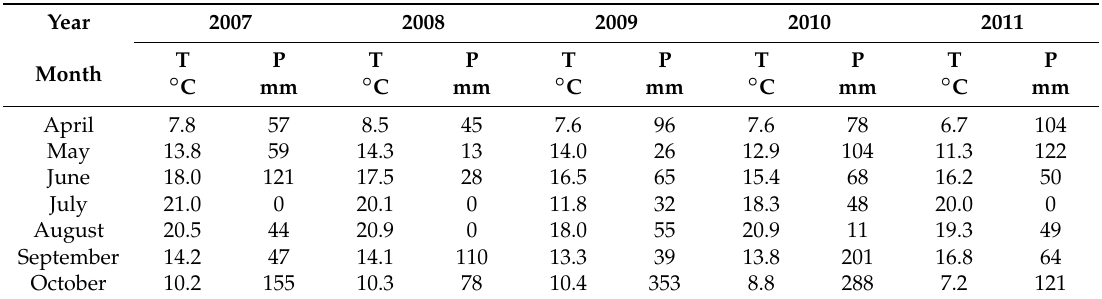
Table 1. Mean monthly temperature (T, ◦ C) and precipitation (P, mm) during the experimental